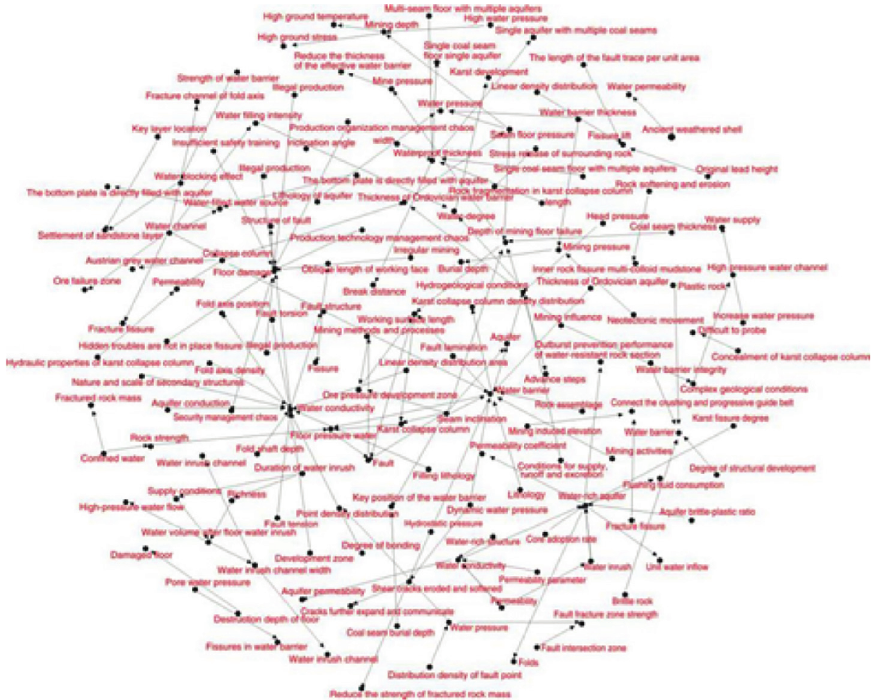
Figure 3: Complex Network model diagram of the coal mine water inrush